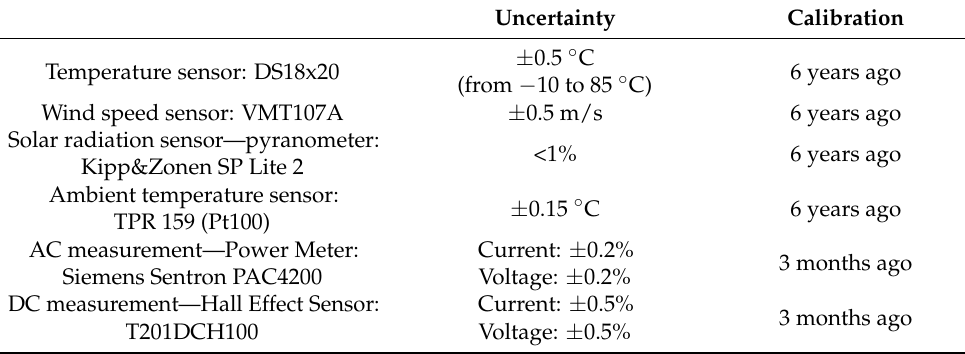
Figure 1. Measurement and experimental system: ( 1 ) Dual-axis PV tracking system; ( 2 ) Ambient temperature sensor; ( 3 ) Solar radiation sensor — pyranometer; ( 4 ) Temperature sensor; and ( 5 ) DC/AC of Maribor. Table 1. Characteristics of measurement devices.